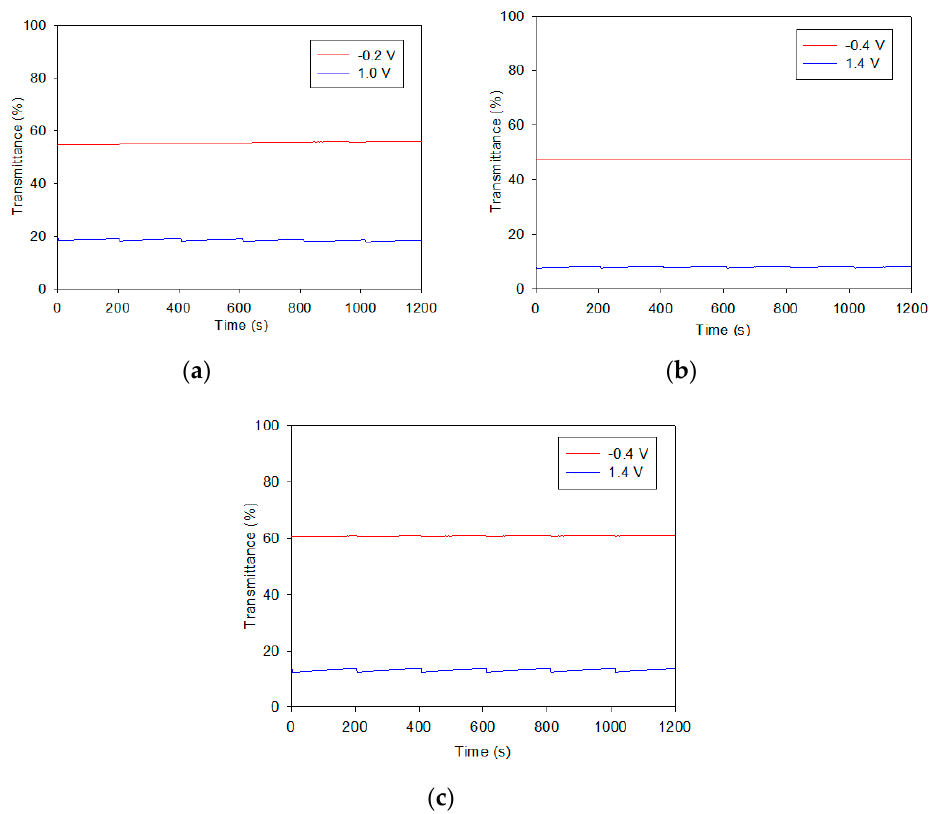
Figure 12. Optical memory effect of: ( a ) PTTPP/PProDOT ‐ Et 2 ECD measured at 588 nm; ( b ) P(TTPP ‐ co ‐ DTC)/PProDOT ‐ Et 2 ECD measured at 590 nm; and ( c ) P(TTPP ‐ co ‐ DTP)/PProDOT ‐ Et 2 ECD measured at 592 nm.